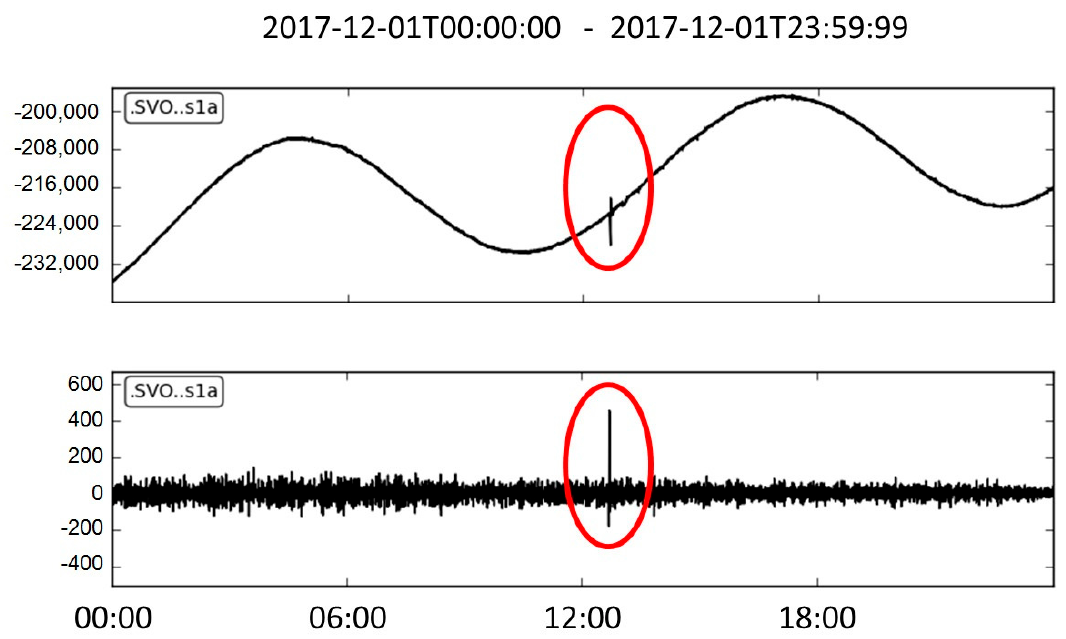
Figure 11. Raw SVO strainmeter (Figure 1) signal (upper panel) and band-pass (0.004–0.02 Hz) filtered SVO strainmeter signal (bottom panel). The red ellipses indicate the 1 December 2017, major explosion. The tidal component is evident on the upper unfiltered signal.